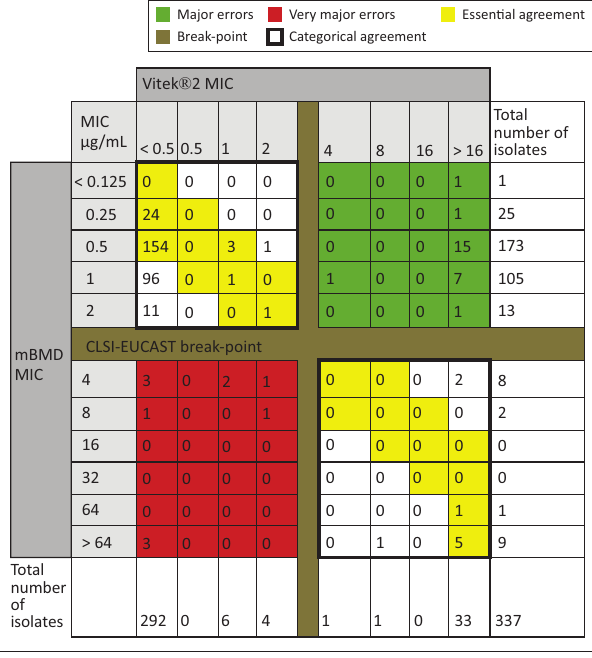
FIGURE 3: Colistin minimum inhibitory concentration (µg/mL) results for XDR A. baumannii complex isolates by both Vitek ® 2 and manual broth micro-dilution.